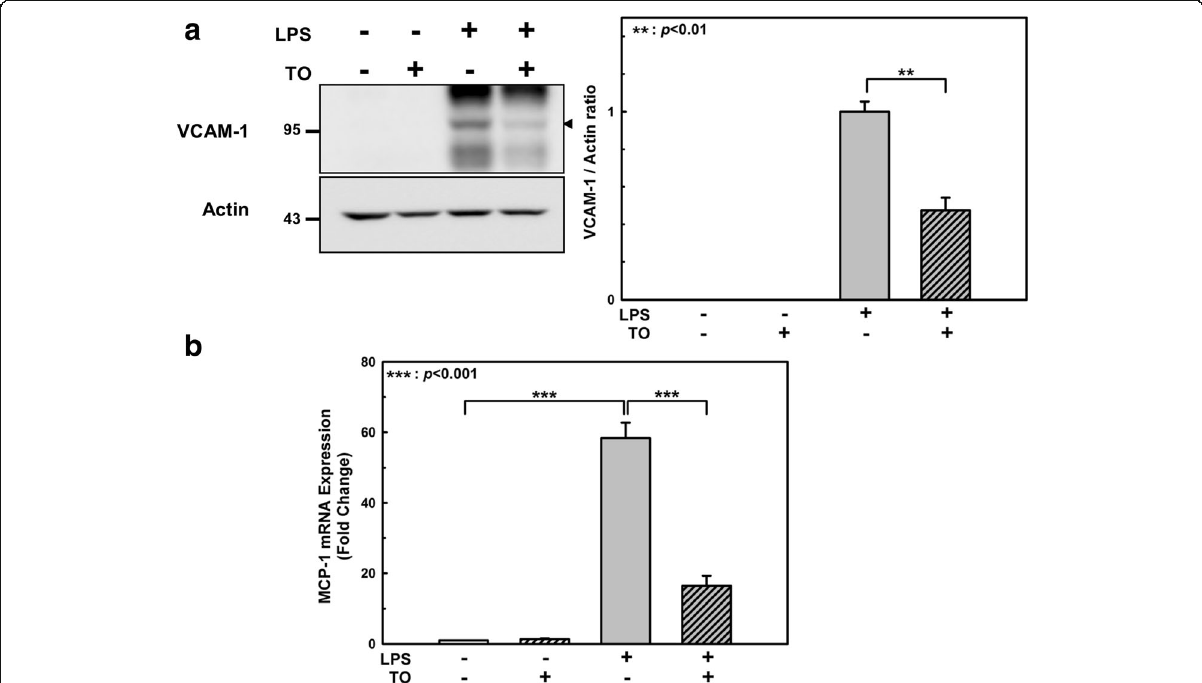
Fig. 3 Effect of the Taraxacum officinale (TO) methanol extract on LPS-induced VCAM-1 and MCP-1 expression. HUVECs were pretreated with TO extract (100 μ g/ml) for 1 h and then incubated with 1 μ g/ml LPS for 24 h. a Total cell lysate was prepared, the proteins were separated by SDS-PAGE, and the VCAM-1 levels were assessed by western blot analysis. b The mRNA levels were normalized to that of a housekeeping gene (18S rRNA) as well as the vehicle-only-treated control, and the 2 - ΔΔ Ct for each mRNA is reported. Results shown are the mean±SE of 3 independent experiments. ** p <0.01, *** p <0.001 vs LPS only